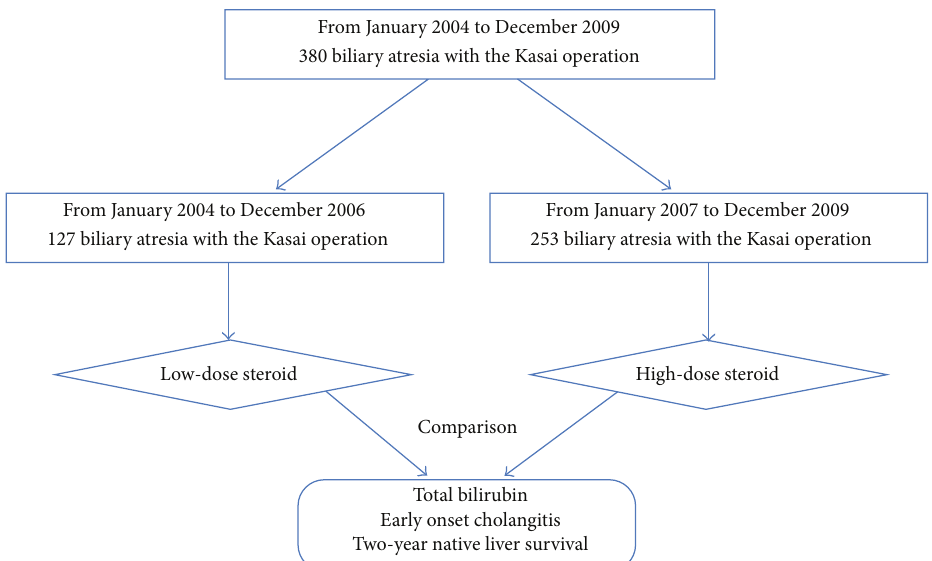
Figure 1: A flow chart of the patient groups and